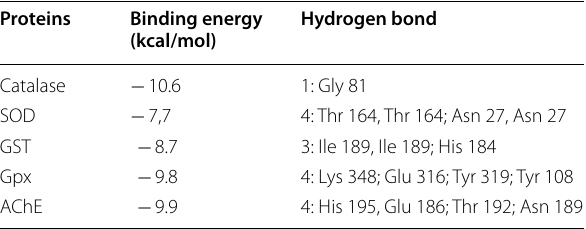
Table 2 Docking binding energy results of Cucurbitacin E as a ligand with enzymes of G.